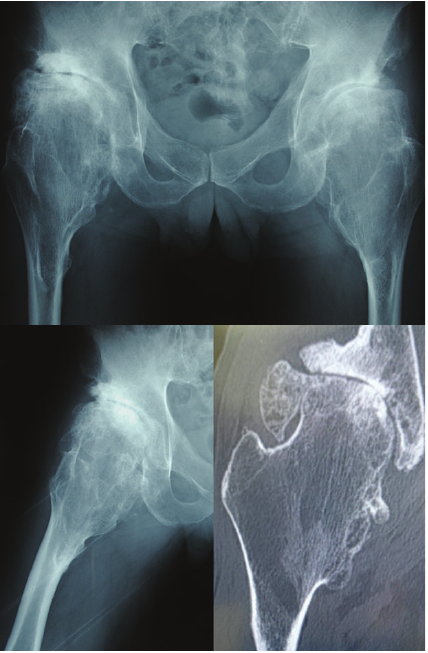
Figure 3: Preoperative radiographs and multidirectional computed tomography image of the right hip joint showing the gigantic femoral head, increasing angle of the neck shaft, and large diameter of the femoral neck.